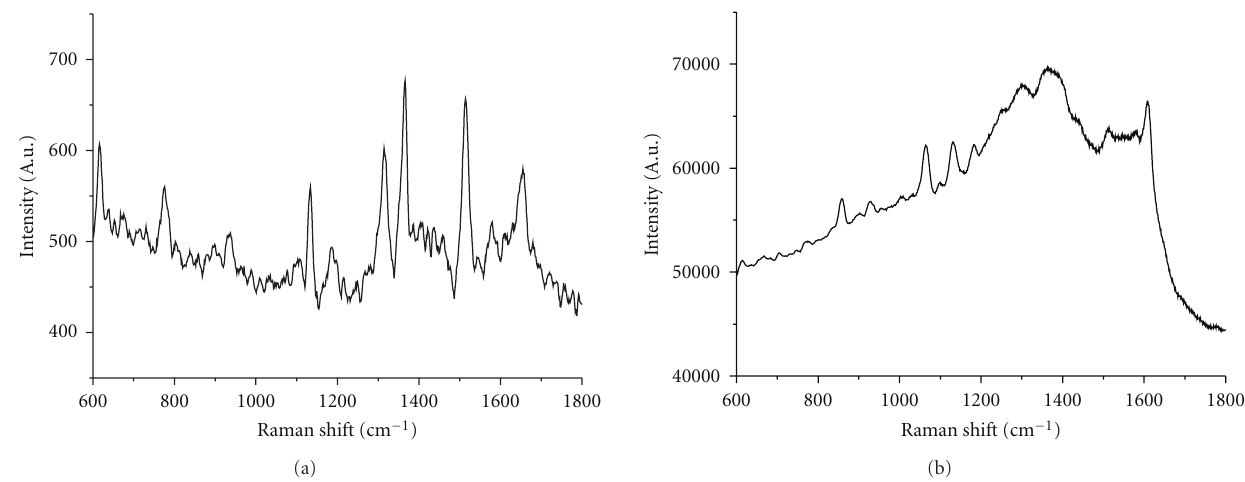
Figure 9: SERS signals detected from (a) direct sampling and (b) liquid-filled HCPCF when the concentration of R6G is 10 − 8 M. While direct sampling can detect R6G signal, liquid-filled HCPCF failed due to an enhanced SNPs background.